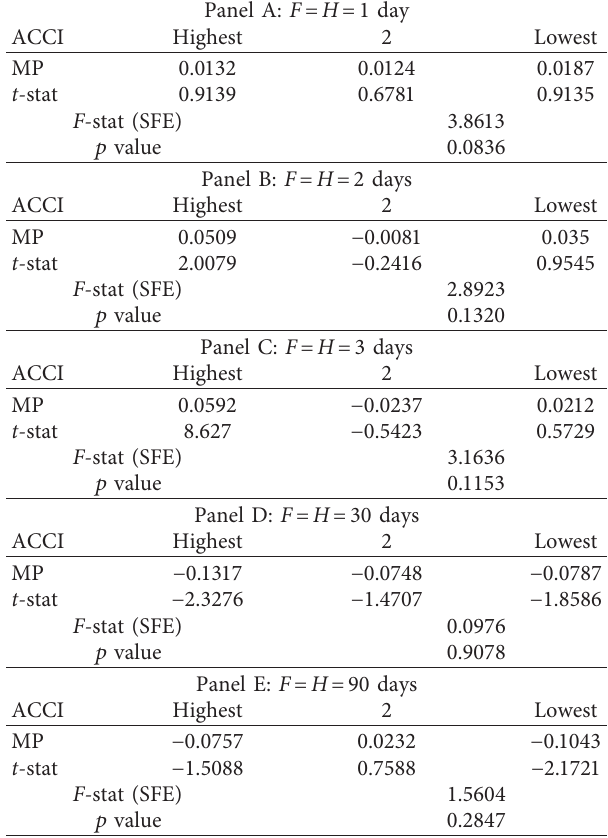
Table 7: The effect of the accumulative relative order imbalance of the B-share